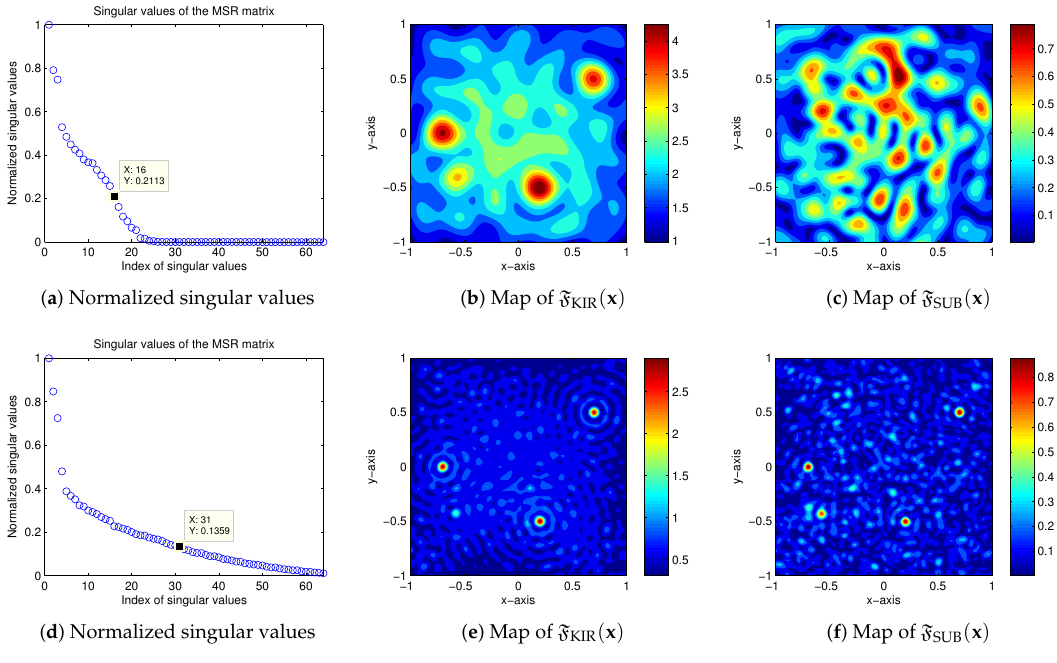
Figure 3. (Example 2: Case 2) Distribution of normalized singular values, maps of F KIR ( x ) and F SUB ( x ) for λ = 0.7 ( top line ) and λ = 0.2 ( bottom line ).